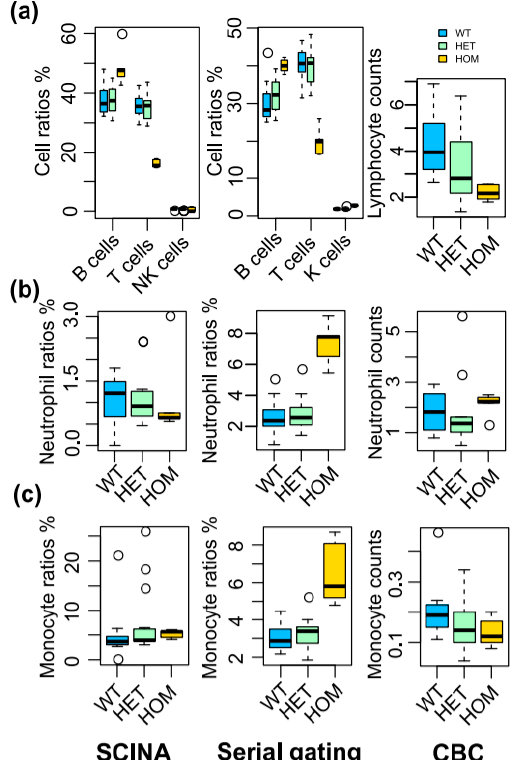
Figure 5. SCINA detects immune cell alterations in Stk4 KO mice. The pedigree contained a total of 12 wild-type (WT) mice, 15 heterozygous (HET) mice, and 5 homozygous (HOM) mice. The relative levels of immune cell populations are detected by SCINA from FACS data (left), the serial gating method from FACS data (middle), and CBC (right). ( a ) Lymphocytes, ( b ) Neutrophils, and ( c ) Macrophages.